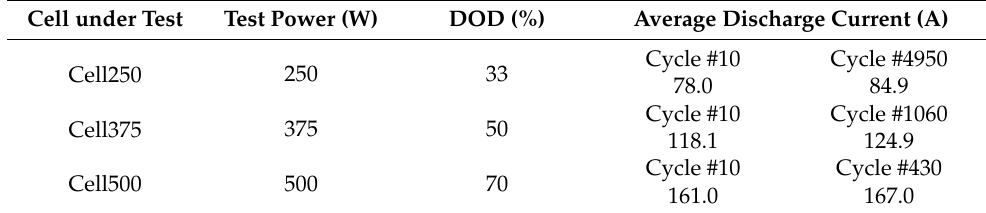
Table 2. Some global parameters of the cycle-life tests.